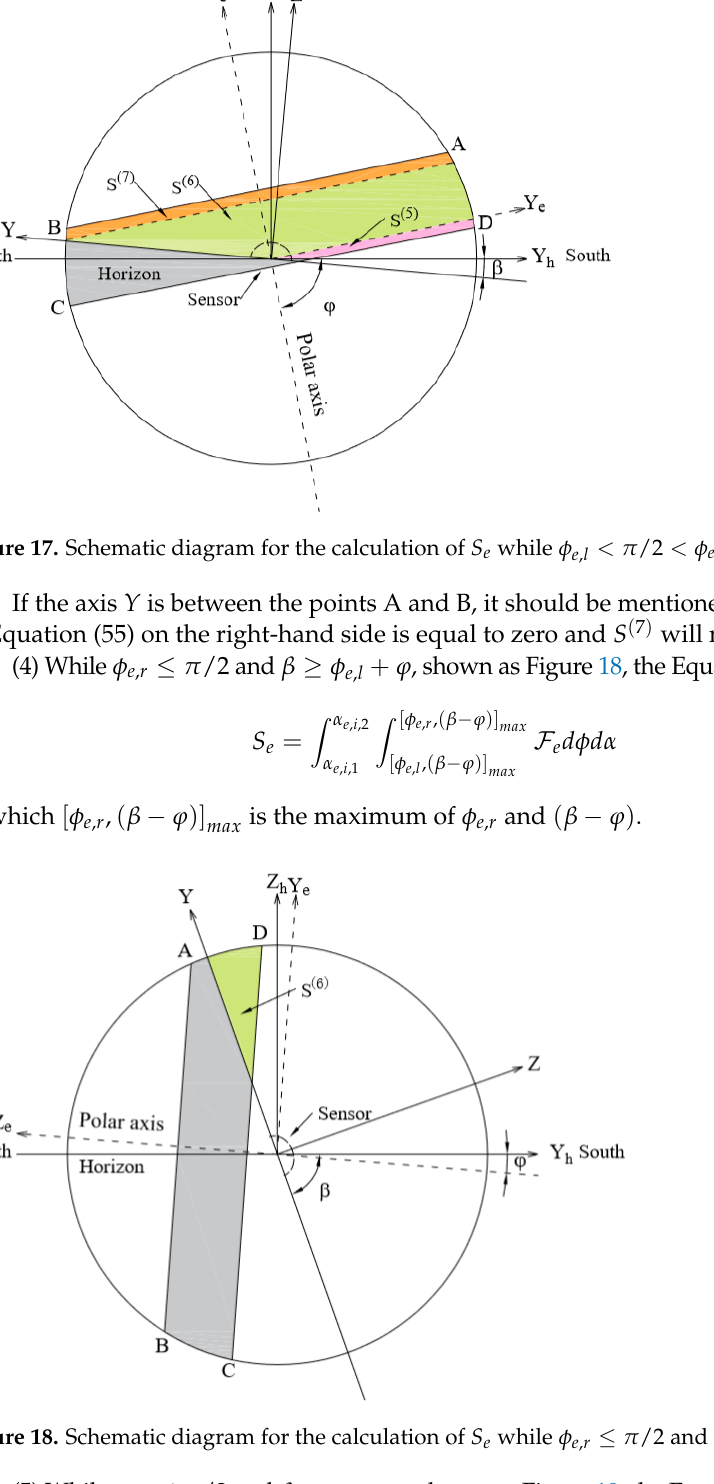
(5) While φ e , r ≤ π /2 and β < φ e , l + ϕ , shown as Figure 19, the Equation (43) will become ≤ 𝜋 2⁄ and β < ϕ + 𝜑 , shown as Figure 19, the Equation (43) will (5) While 𝜙 (cid:3032),(cid:3045) (cid:3032),(cid:3039)